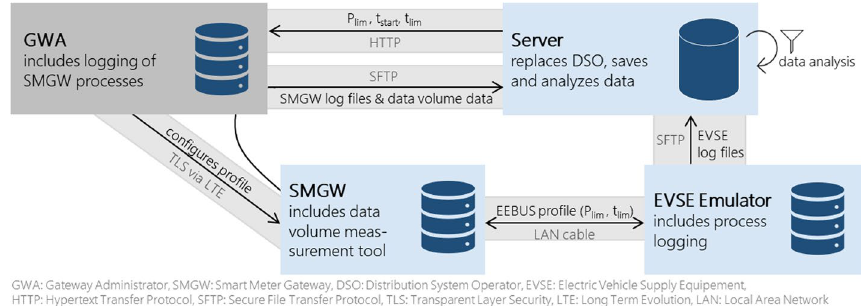
Fig. 4 Test setup, data collection and its transmission for the performance